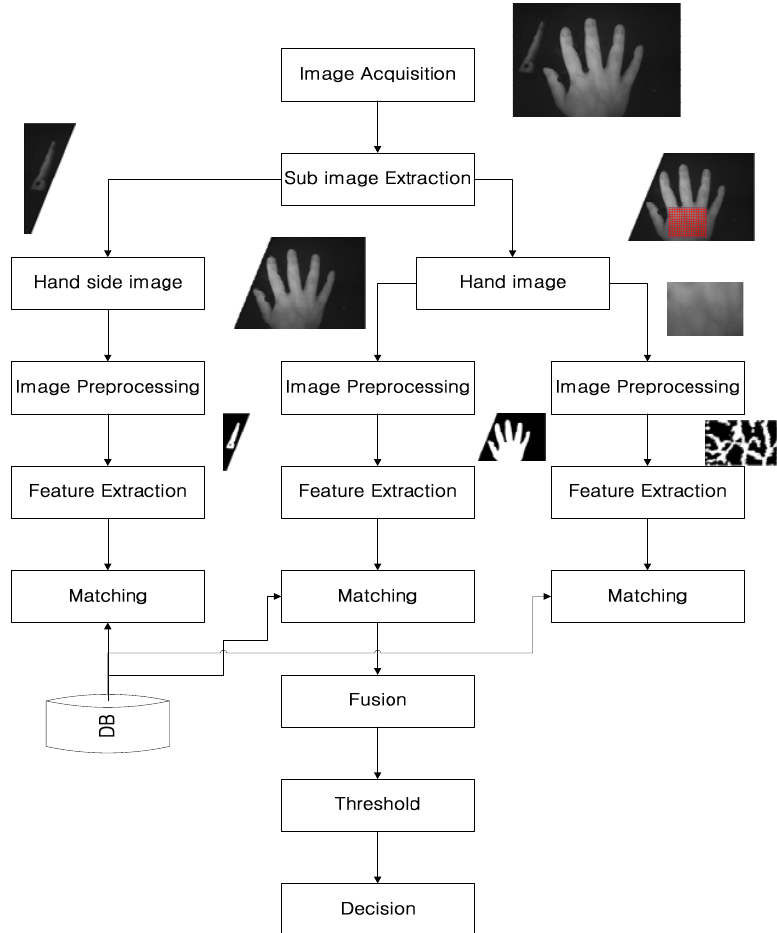
Figure 1. Block diagram of the implemented